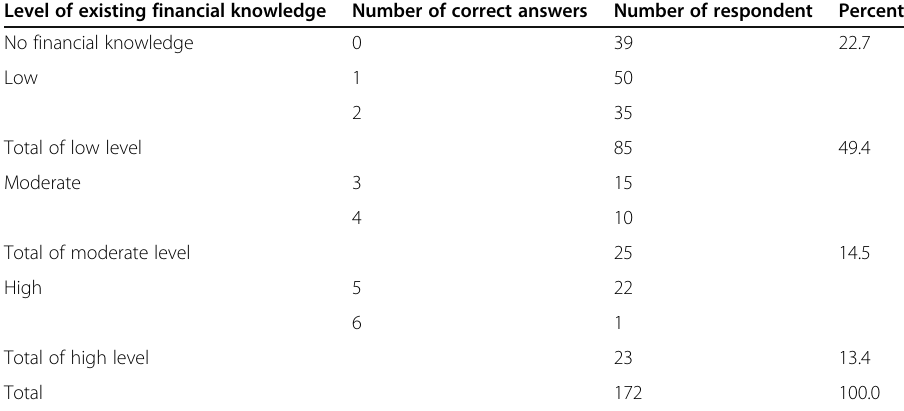
Table 2 Level of restaurant entrepreneurs ’ existing financial knowledge Level of existing financial